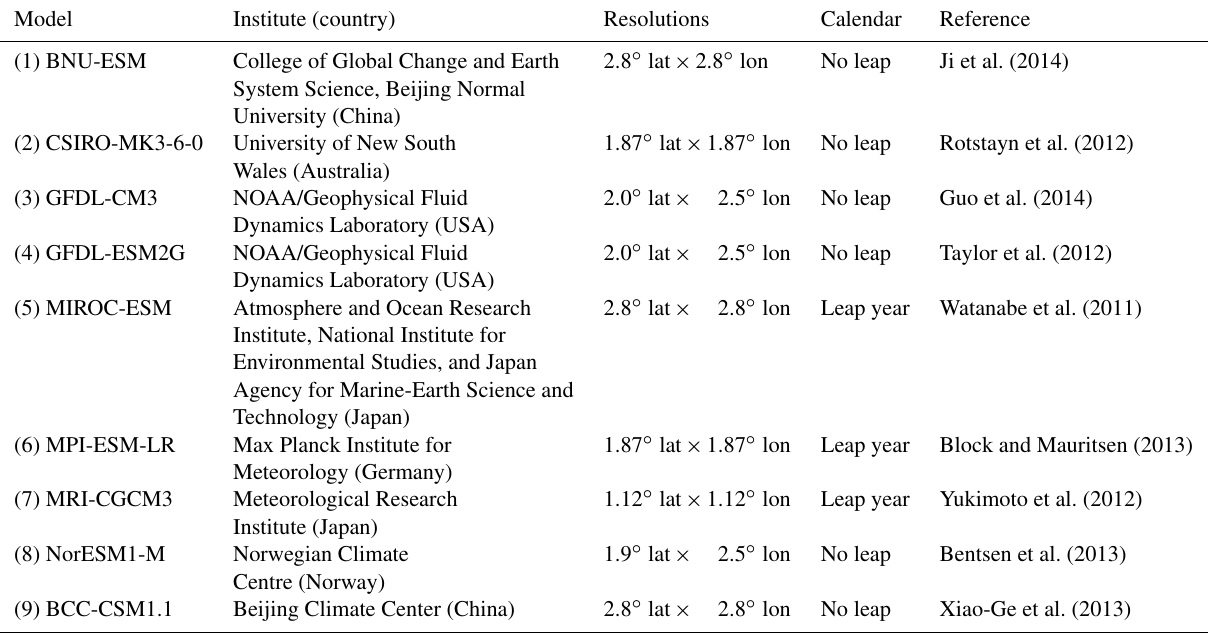
Table 2. Description of the CMIP5 models used in this study.